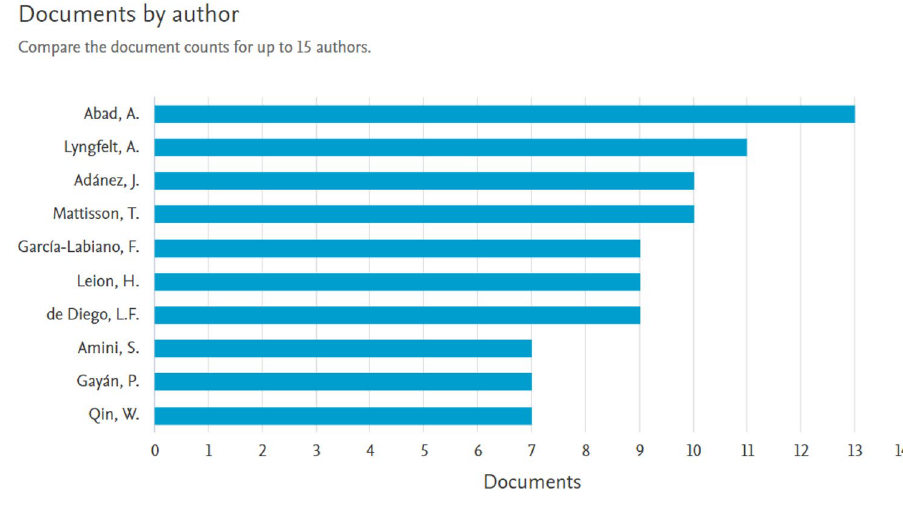
Fig. 3 Documents by Area of Study (Source: www.